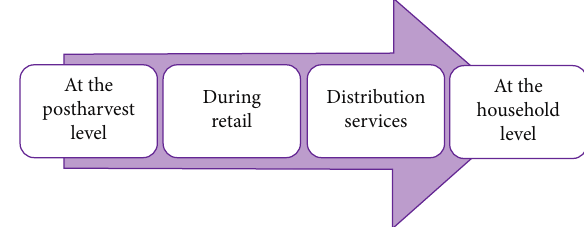
Figure 2: Illustration of the generation of cotton